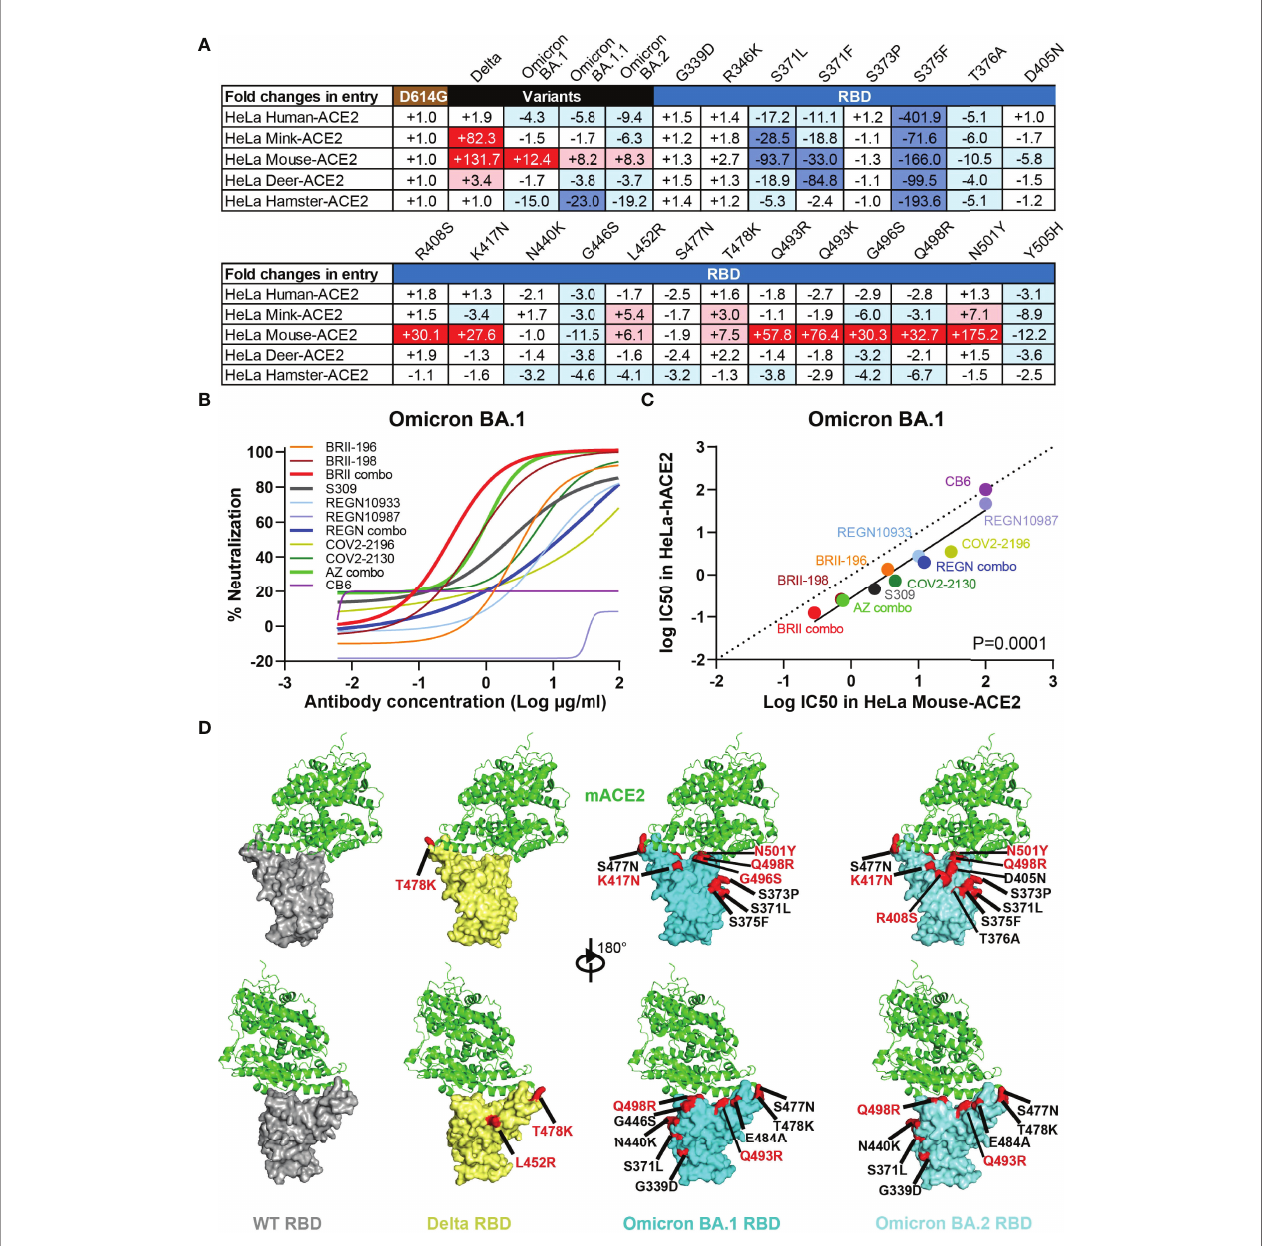
FIGURE 5 | Omicron variants acquire usage of mouse ACE2 and reduces sensitive to antibody neutralization. (A) Entry ef fi ciency of SARS-CoV-2 Delta, Omicron BA.1, BA.1.1, BA.2, and 21 single mutant pseudoviruses into HeLa cell lines ectopically expressing various host ACE2. The values represent the fold changes in luciferase activity relative to D614G. The symbol “ + ” indicates an increase while “ - ” indicates a decrease in entry ef fi ciency. Red color highlights at least threefold increase in entry ef fi ciency; blue indicates at least threefold decrease in ef fi ciency, while white indicates no change greater than threefold. Results were derived from two independent experiments. (B) Neutralizing sensitivity of Omicron BA.1 to each therapeutic antibody and designated combinations, measured in HeLa cells expressing mouse ACE2 (HeLa Mouse-ACE2). Results were calculated from two independent experiments. (C) Correlation between IC50 for each antibody and designated combinations against BA.1 pseudovirus measured in HeLa-hACE2 and HeLa Mouse-ACE2. The R 2 and P values for correlation were 0.9193 and 3.2e-6, determined by two-tailed Spearman correlation. Linear regression of experimental Log IC50 was estimated (solid line) and compared with a hypothetical regression (dotted line) for assumption of equal IC50s in both HeLa-hACE2 and HeLa Mouse-ACE2. Neutralizing activity was signi fi cantly higher in HeLa-hACE2 cells than that in HeLa Mouse-ACE2 (P = 0.0001). (D) Structural modeling of mouse ACE2 binding to RBD of WT, Delta, Omicron BA.1, and BA.2. Structure of mACE2 binding to a lethal mouse adapted SARS-CoV-2 RBD in grey (PDB:7FDK). Docking of mACE2 onto the Delta RBD in yellow (PDB:7WBQ), or onto Omicron BA.1 and BA.2 RBD in cyan (PDB:7WBP). The major substitutions found in the RBD of studied variants are indicated and those in red showed substantial enhancing effect on entry into HeLa Mouse-ACE2 cell